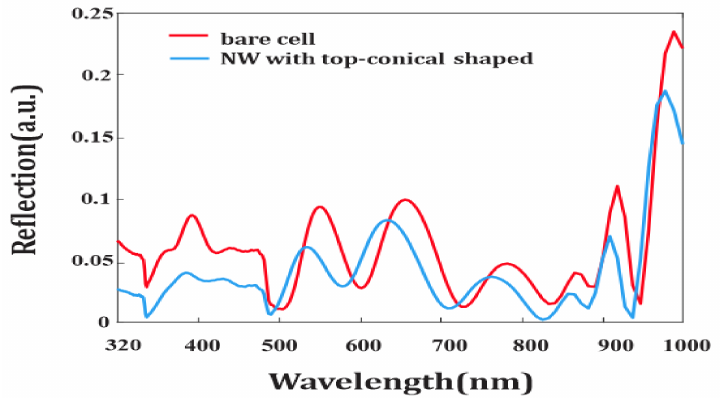
Figure 3. Reflection spectra for the bare cell and for the NWs with conical-shaped